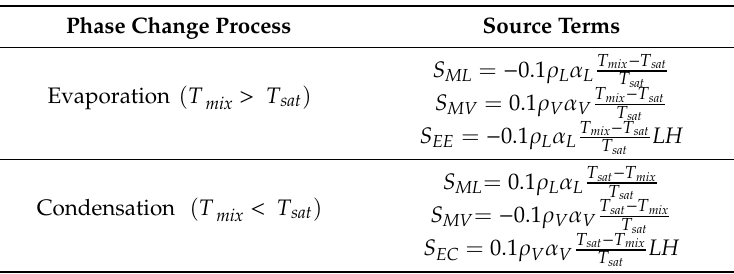
Table 1. Source terms during phase change process.